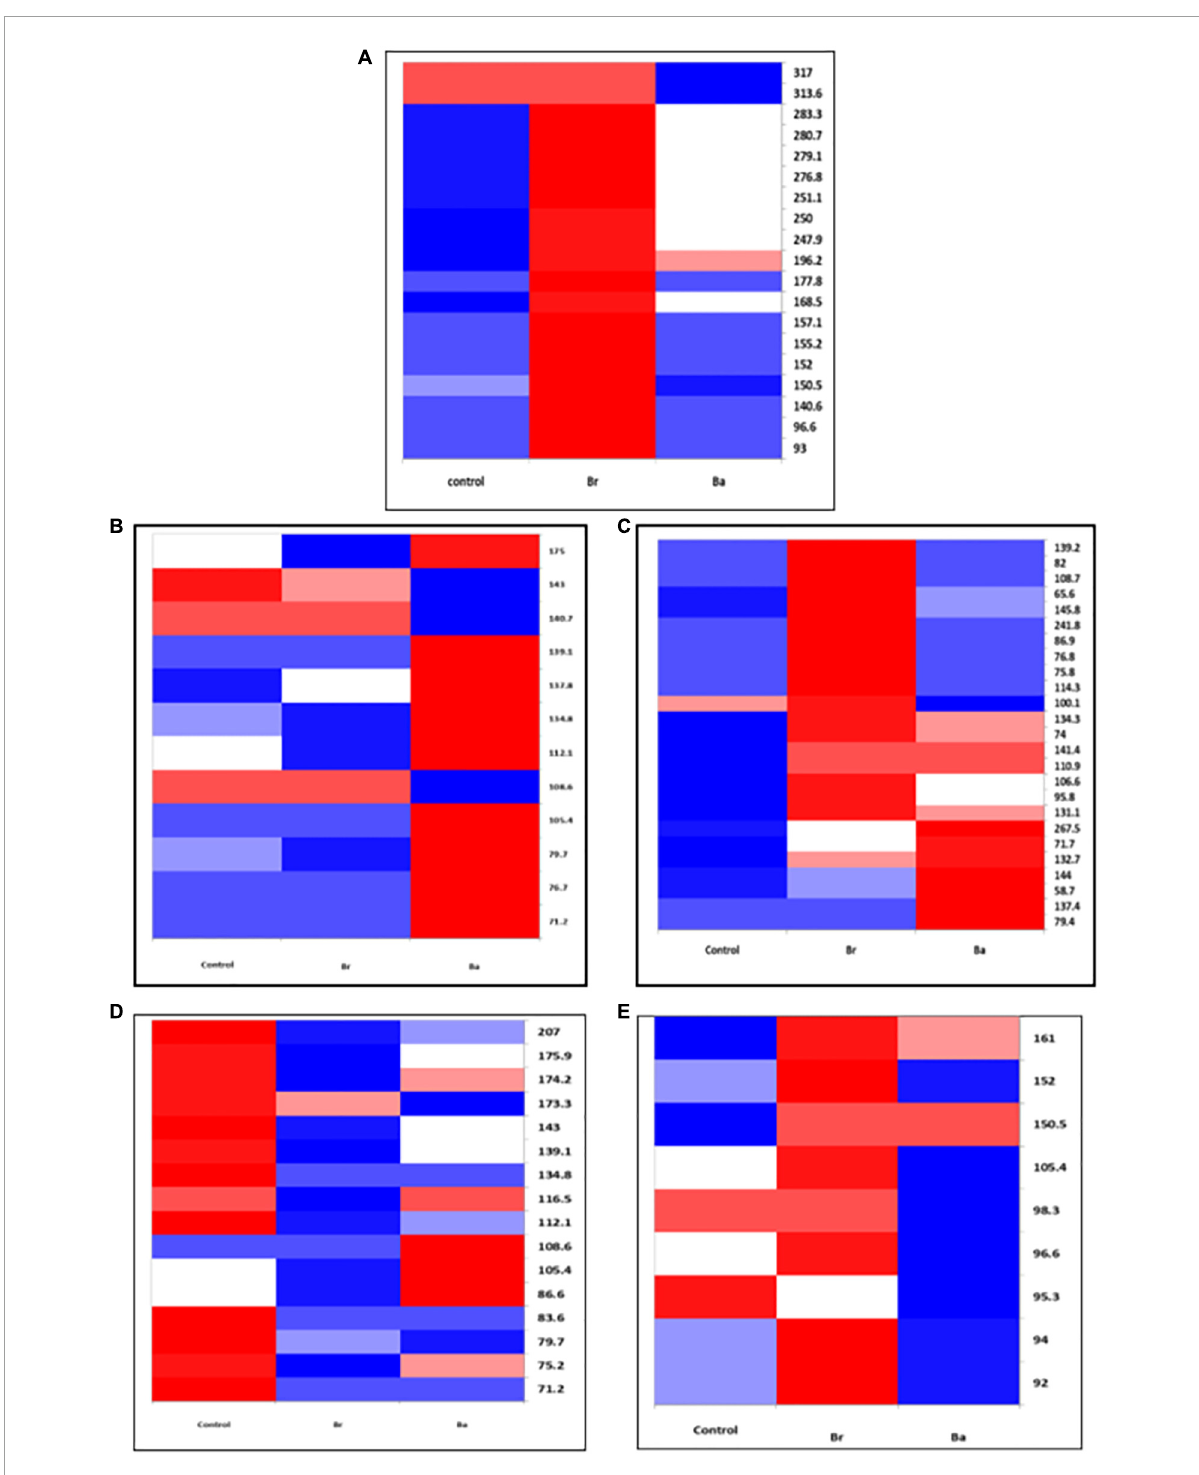
FIGURE1 Heatmap displaying the occurrences of the common bacterial operational taxonomic units (OTUs) identified, as T-RFs, in the soils treated with Beauveria brongniartii (Br) and Beauveria bassiana (Ba) bioinocula and untreated (Control) in the field located at Nowa Wola (NOW) as sampled during the 3 years. The color represents the OTU intensity: Blue to red, min to max. The absence of OTU is displayed as white line. The intensity of the color represents the percentage of occurrence in the treatment. Samples were collected in (A) September 2014, (B) June 2015, (C) September 2015, (D) May 2016, and (E) July